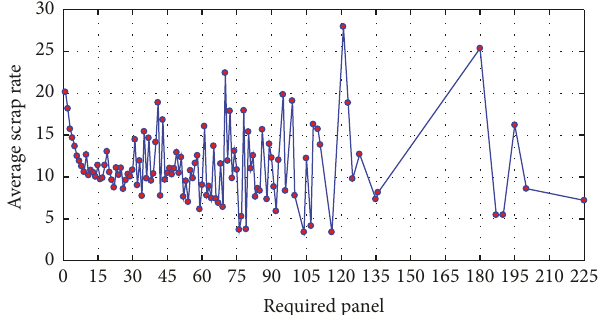
Figure 5: Average scrap rates with different required